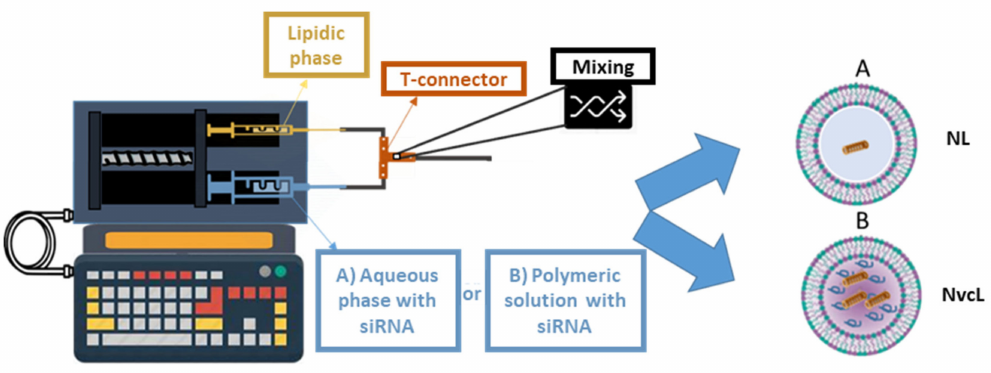
Figure 1. Graphical representation of push syringe technique for the preparation of ( A ). Neutral Liposomes (NLs) and ( B ). Neutral viscous core Liposomes (NvcLs).